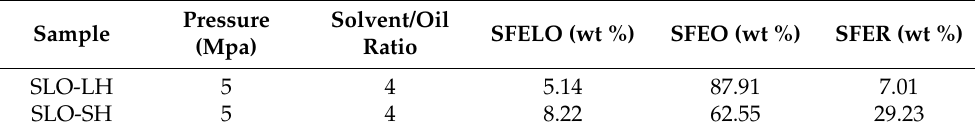
Table 2. Operating parameters of SFE and yield of extraction